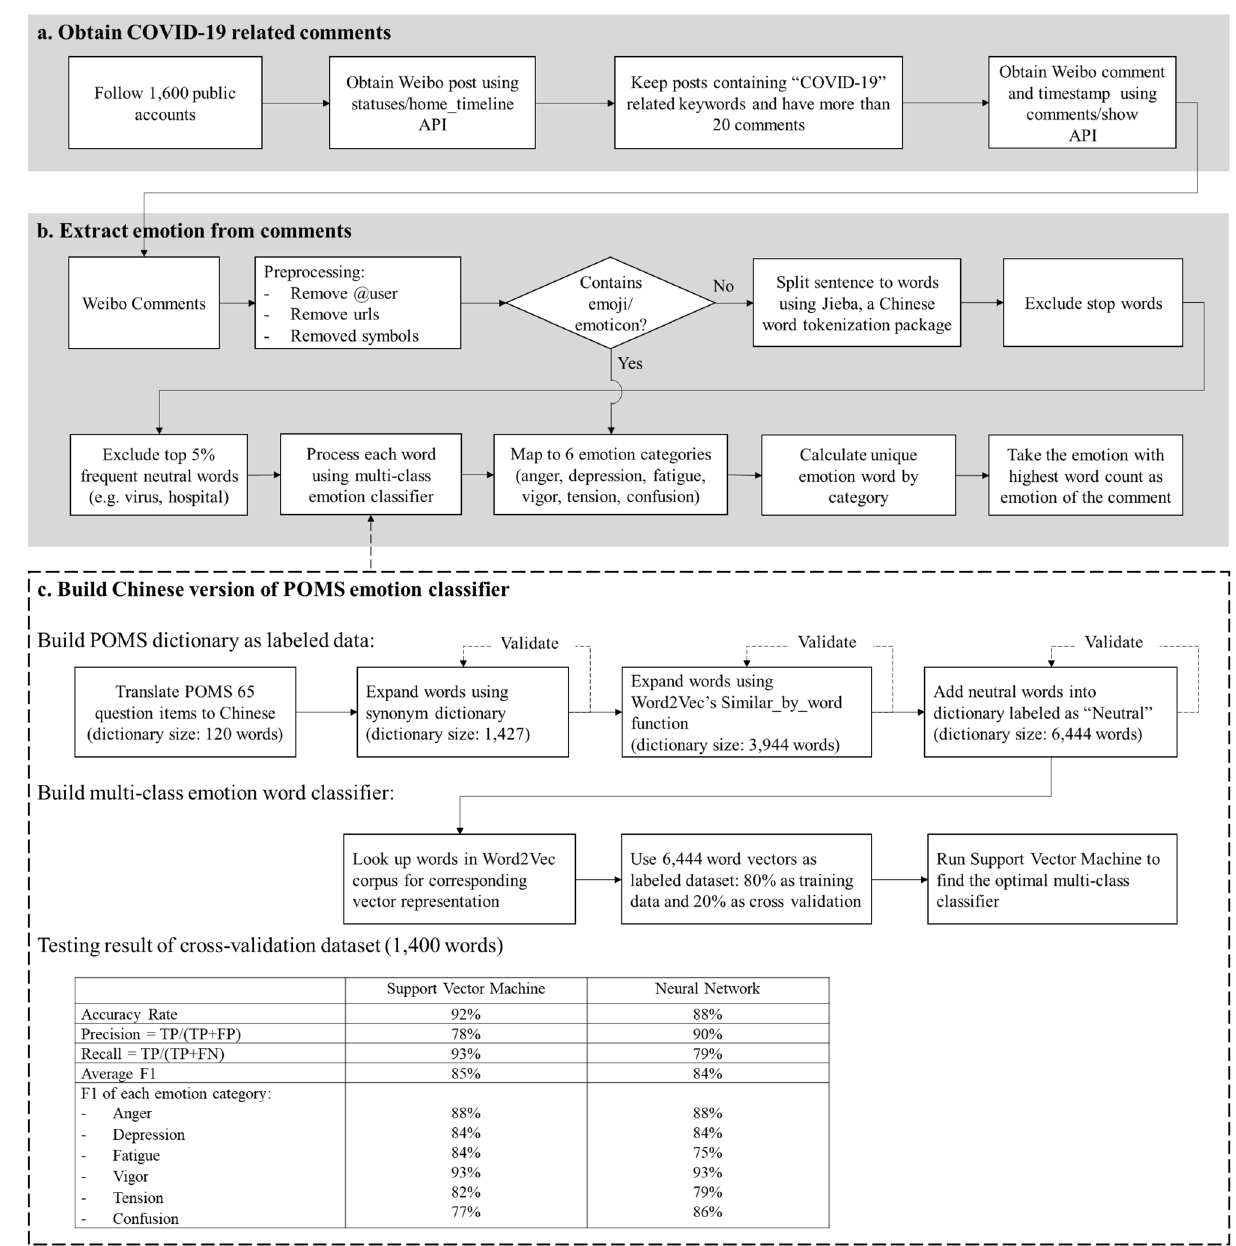
Figure 8. Process to detect emotion from the COVID-19 related comments. ( a ) Process to obtain the COVID- 19 related comments using open Weibo API. The COVID-19 related keywords are { 疫情 (epidemic/pandemic), 肺炎 (pneumonia), 感染 (infection), 病毒 (virus), 新冠 (coronavirus), 隔离 (quarantine), 核酸 (PCR test), COVID}. ( b ) The algorithm to pre-process comment data, tokenize into words and then label each comment with either a POMS emotion or neutral tag by looking at each word’s emotion classification. ( c ) The process to build the Chinese version of POMS emotion classifier combining dictionary-based and machine learning algorithm. The training result shows that the performance between Support Vector Machine and Neural Network are similar in general. We adopted Support Vector Machine which gives better accuracy